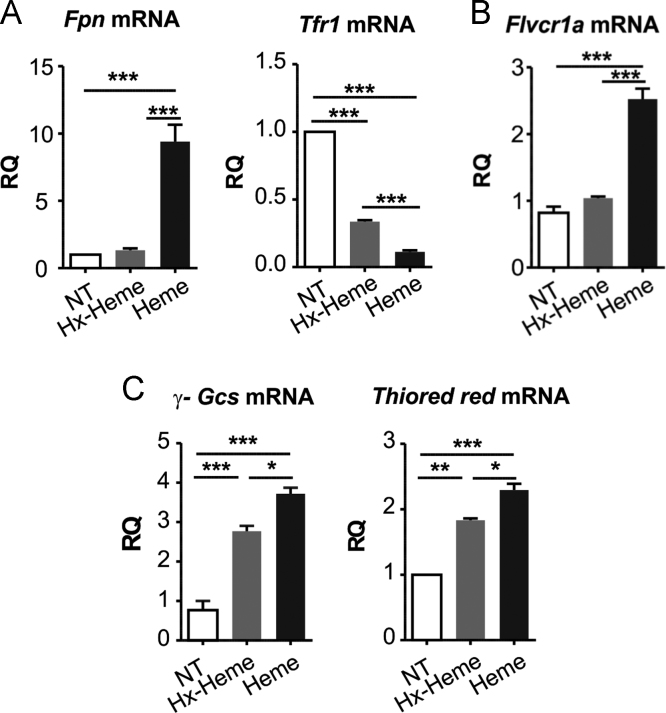
Hemopexin protects neonatal cardiomyocytes and H9c2 cells from heme accumulation and ROS formation. Data on neonatal cardiomyocytes and H9c2 cells untreated (NT) or treated with either 10 µM Hx-heme complex or 10 µM heme for 8 hours, are shown. (A, C) qRT-PCR analysis of Fpn, Tfr1, γ-Gcs and Thioredoxin reductase mRNA levels of neonatal cardiomyocytes. (B) qRT-PCR analysis of Flvcr1a mRNA levels of H9c2 cells. One-way analysis of variance with Bonferroni post-test analysis was performed. *P < 0.05; **P < 0.01; ***P < 0.001.